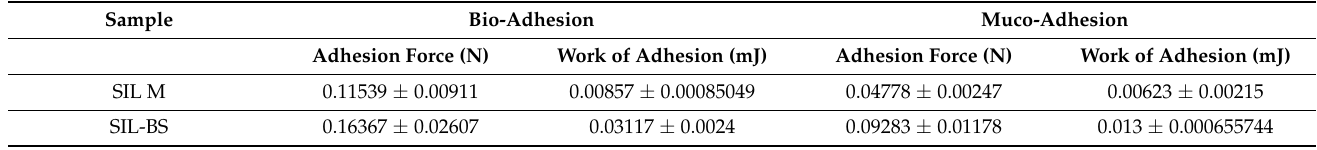
Table 5. The results of the bio/muco-adhesion tests of the studied compounds. Sample